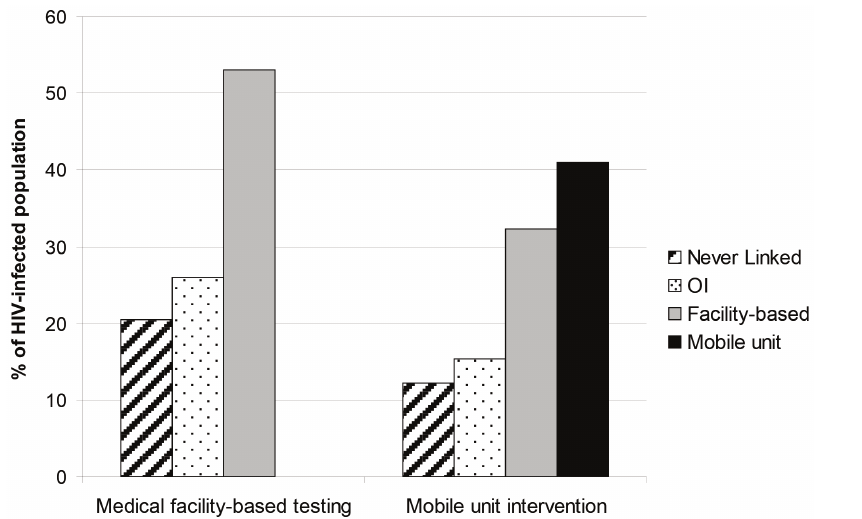
Figure 1. Model-derived mechanisms of HIV linkage in Cape Town, South Africa. The charts display the proportion of HIV-infected individuals linked to care with the medical facility-based strategy, and the mobile unit intervention strategy. HIV: human immunodeficiency virus, OI: Opportunistic Infection. doi:10.1371/journal.pone.0085197.g001 PLOS ONE |